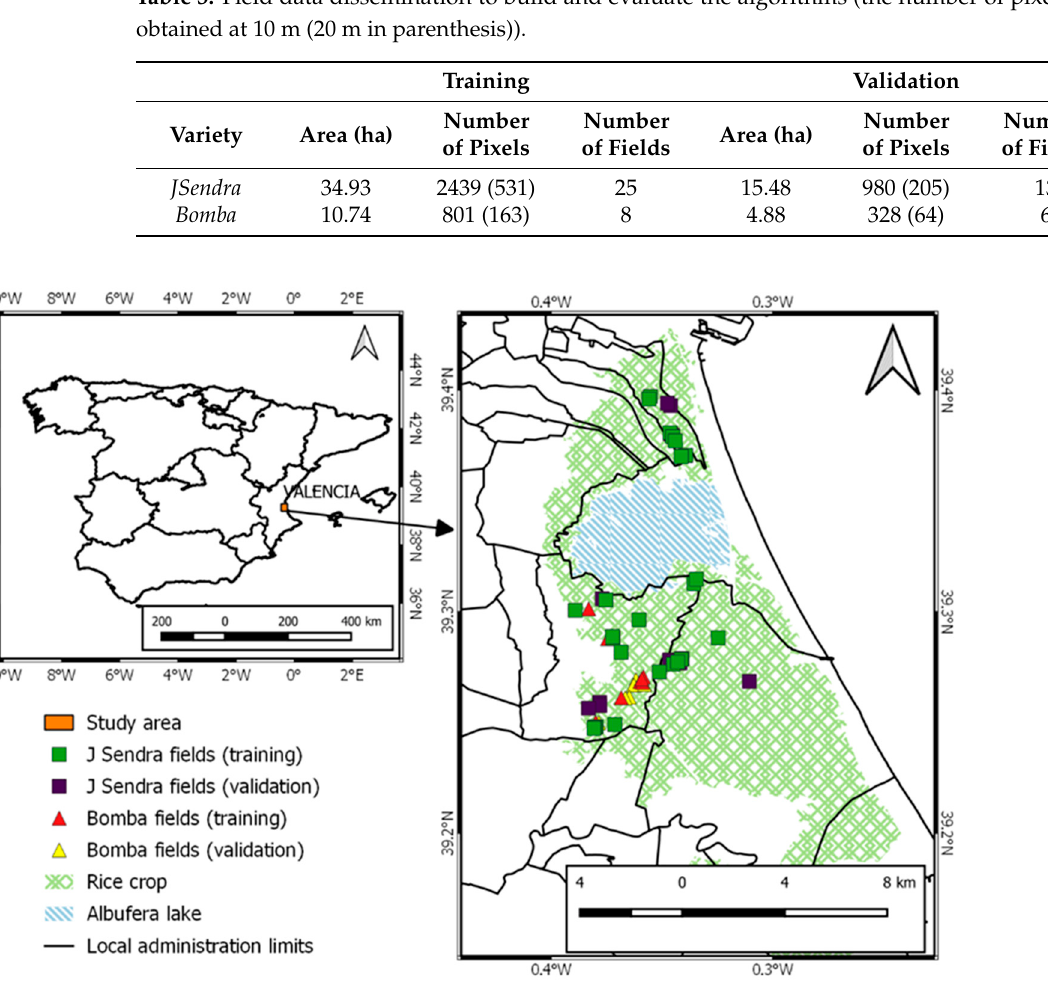
Table 2. Sentinel-2 bands analyzed in this study.